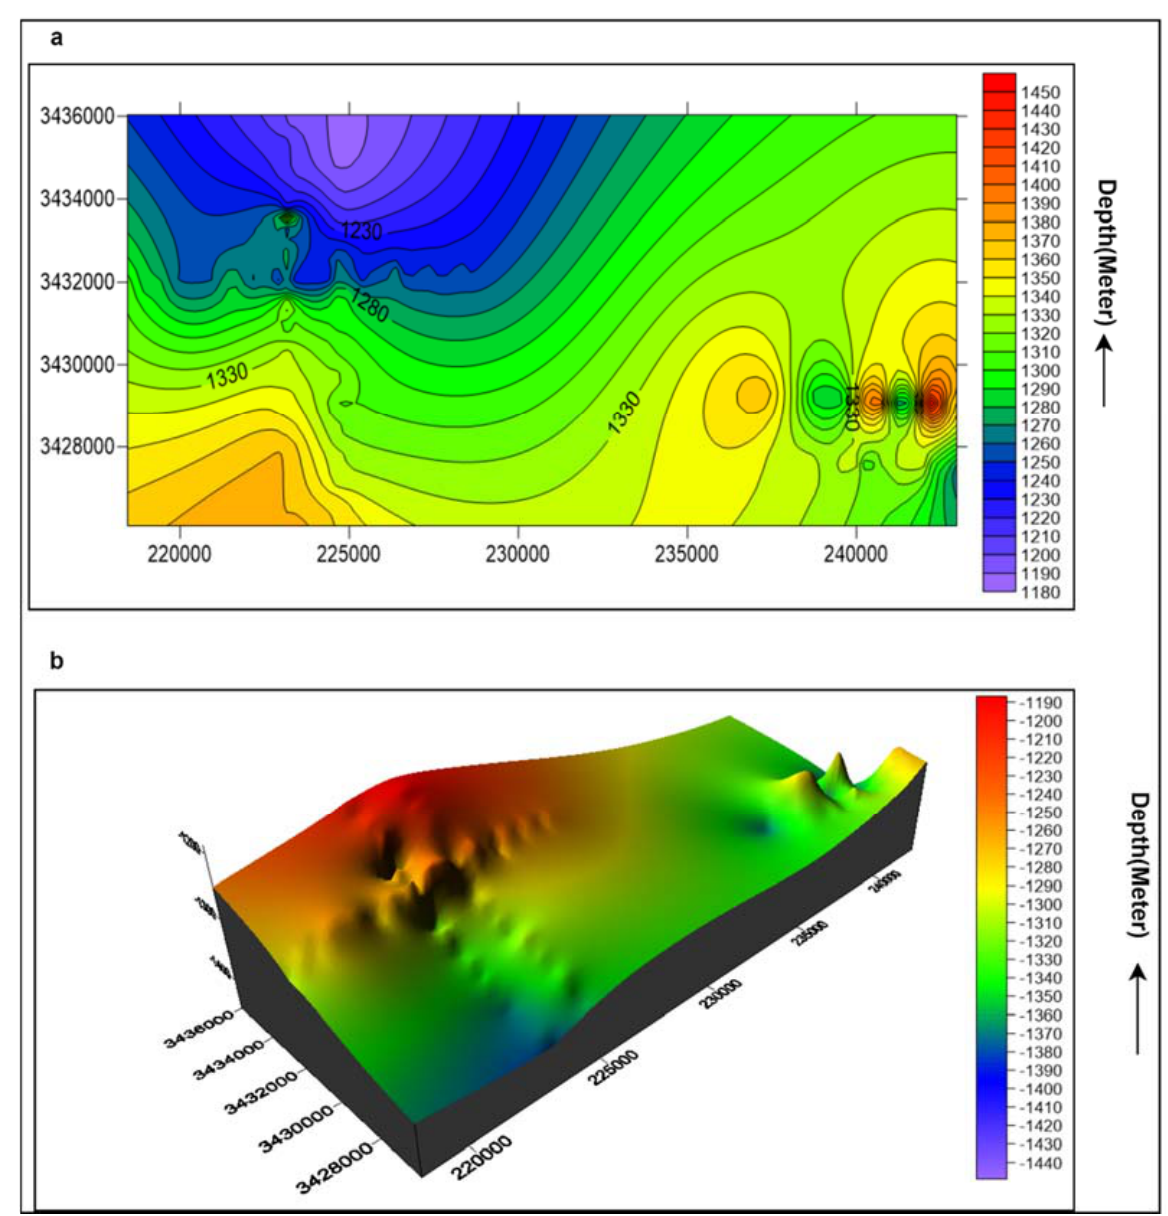
Figure 14. ( a ). Depth contour map of the Datta formation. ( b ). Depth surface map of the Datta for- Figure 14. ( a ) Depth contour map of the Datta formation. ( b ) Depth surface map of the Datta formation. mation. The depth contour map of the Warcha formation uses a similar template as the Datta formation. The inclusive structure is the monocline structure of the Punjab platform, even though fluctuating variations in depth are shown. The decrease in depth value is from 2400 to 1940 m, as shown in Figure 15a. The depth contour surface of the Warcha formation was generated by joining the points of equal depth. These depth values were assigned a color bar, which can be used as a guide for interpretation. On the color bar, red shows the shallowest point and purple-blue shows the deepest point (Figure